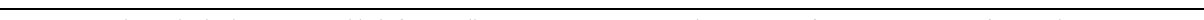
Fig. 1 Stress granules and P-bodies are assembled after B-cell activation. a Quantitation by RT-qPCR of mRNA expression of PBs and SGs components in B cells after LPS activation. Data from at least two independent experiments are shown as mean + s.e.m. (Mann – Whitney test, ns non-signi fi cant, * P < 0.05, ** P < 0.01, *** P < 0.001). b Immunoblot analysis of Dcp1a and Tia1 protein abundance in LPS- activated B cells. c Visualization of Dcp1a and Tia1 containing granules in ex vivo and LPS-activated B cells by confocal microscopy. Nuclei were stained using Dapi. The number of Dcp1a and Tia1- containing granules per cell is shown in the right panels . Quantitation was performed using Volocity Image software based on fl uorescence accumulation within granules. A minimum of six confocal images from three independent experiments were analyzed. Data shown as mean + s.d. Statistical analysis of the number of objects in treated B cells compared to untreated B was performed using a Mann – Whitney test. ( Scale bar = 10 μ m). d Detection and feature distribution analysis of Tia1 binding to its mRNA targets in the cytoplasm of B cells treated with LPS for 48 h. Top panel , autoradiography showing Tia1:RNA complexes labelled with 32 P-ATP after complete or partial RNA digestion with RNaseI. Red box indicates the RNA:protein complexes puri fi ed for cDNA library preparation and iCLIP analysis. Bottom panel , distribution analysis of iCLIP cDNA counts mapped to the indicated genomic features (3 ′ UTR, 5 ′ UTR, ORF, intergenomic, intron and ncRNA). Data from the two Tia1 iCLIP experiments performed using B-cell cytoplasmic extracts are shown. e Venn diagram showing the number of Tia1 mRNA targets identi fi ed in two iCLIP experiments. Only mRNA targets with at least one signi fi cantly enriched binding site in the 3 ′ UTR were considered (transcripts collapsed by gene id, peak enrichment analysis, FDR < 0.05). f Gene ontology (GOrilla and REViGO) analysis of Tia1 mRNA targets in activated B cells. Genes which expression was detected in our mRNAseq libraries from LPS-activated B cells was used as a background gene list for GO enrichment analysis. Bubble plot sizes indicate the generality of the GO terms. Larger bubbles relate to general terms